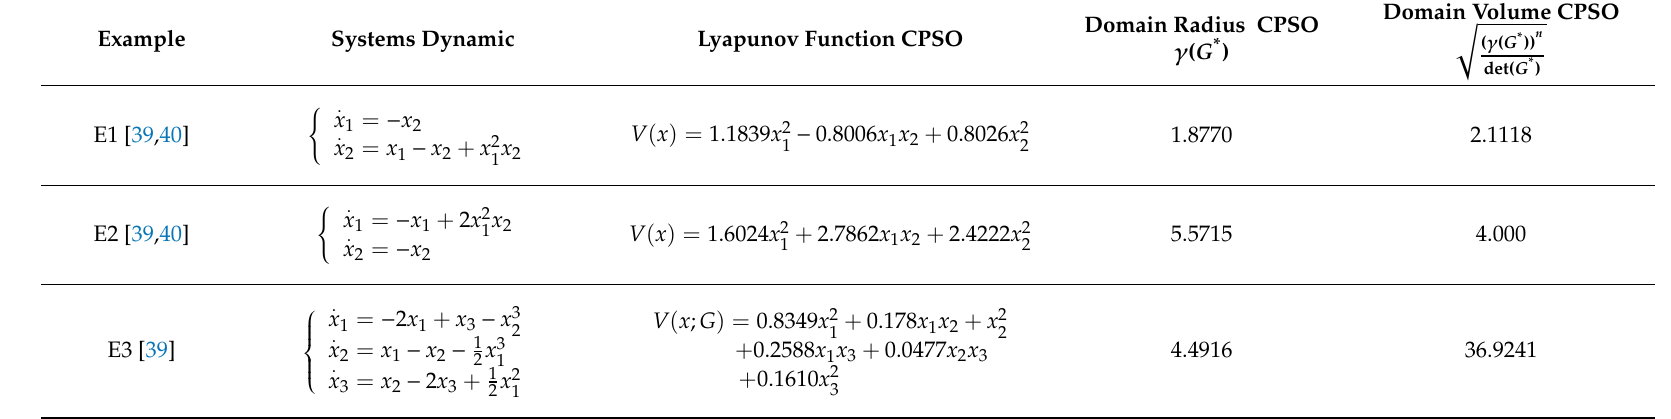
Table 1. Benchmark nonlinear systems using defined quadratic LF calculated with the proposed CSPO algorithm in this paper.